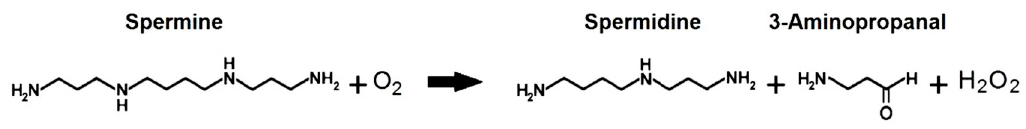
Figure 4. Enzymatic reaction catalyzed by SMOX. The physiological substrate spermine (Spm) is oxidized by the SMOX enzyme into spermidine (Spd) with the production of 3-aminopropanal and hydrogen peroxide.